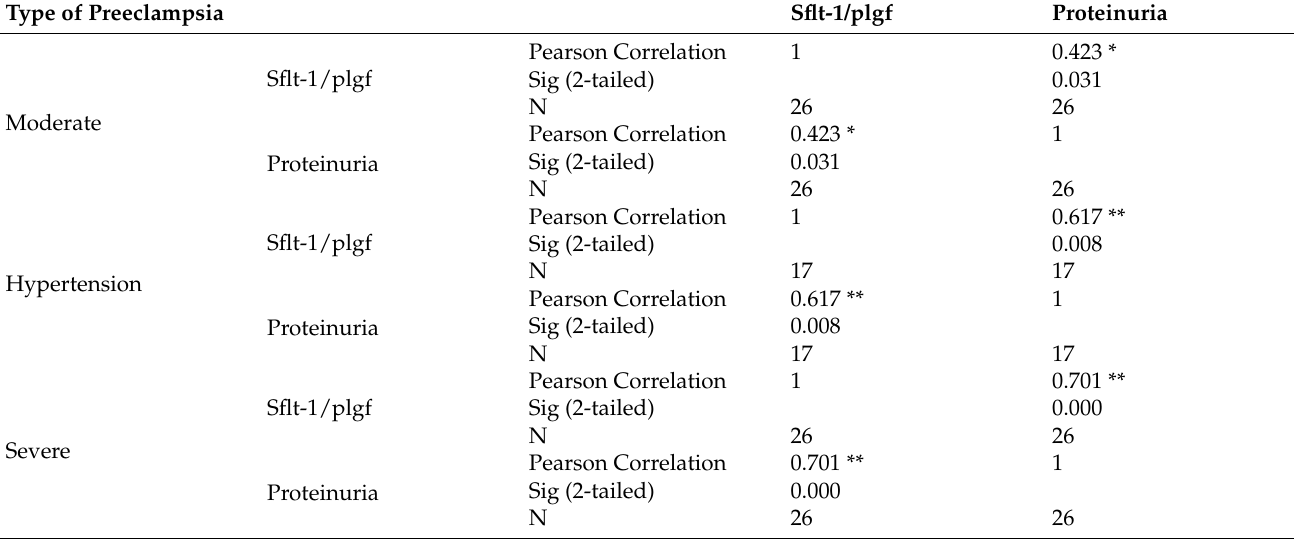
Table 4. Correlation between proteinuria and values of